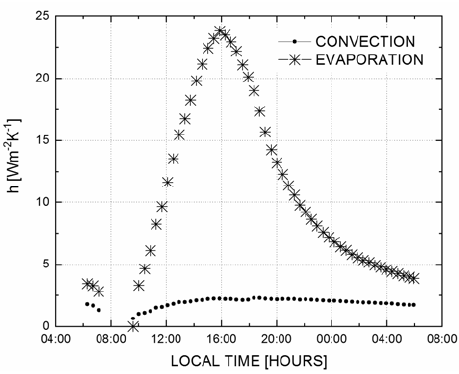
Figure 3. Relevance of the evaporative mode of heat transfer in solar distillation.